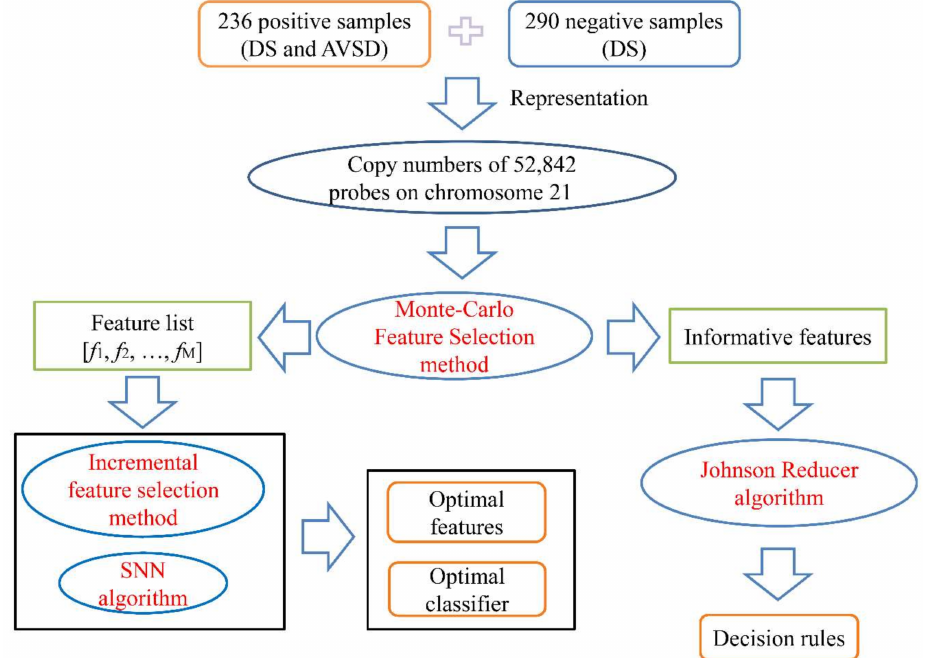
Figure 1. Flowchart of our proposed pipeline. 236 patients with both Down syndrome (DS) and atrioventricular septal defect (AVSD) (positive samples) and 290 patients had only DS (negative samples) were measured by the copy numbers of 52,842 probes on chromosome 21. Then, all features were evaluated by Monte Carlo feature selection method (MCFS), resulting in a feature list and several informative features. The feature list was used in the incremental feature selection method to construct an optimal self-normalizing neural network (SNN) classifier and extract optimal